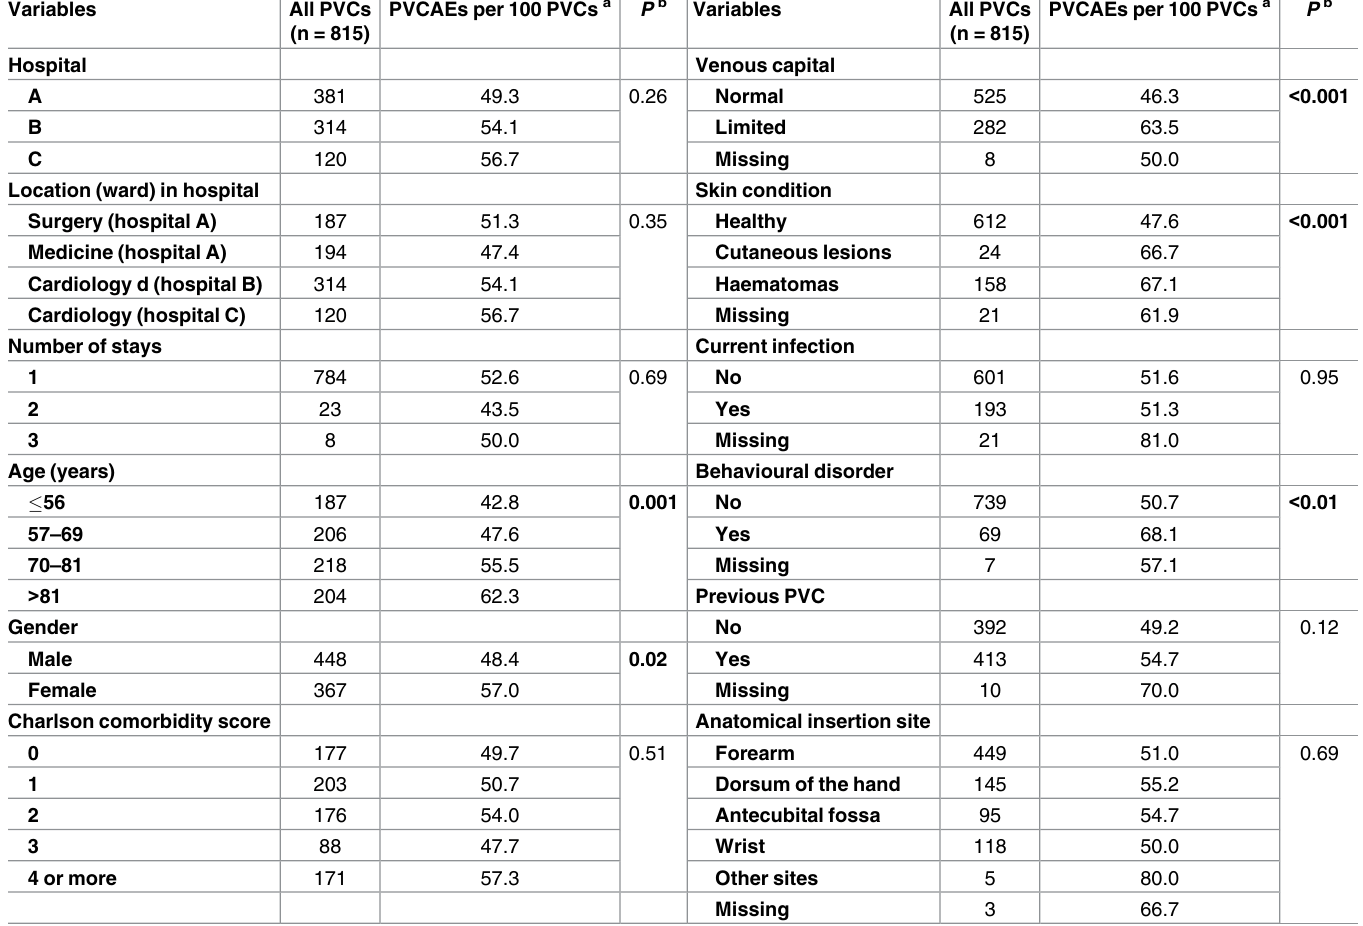
Table 5. Incidence of at least one PVCAE according to patient characteristics in univariate analysis, n = 815 PVCs.